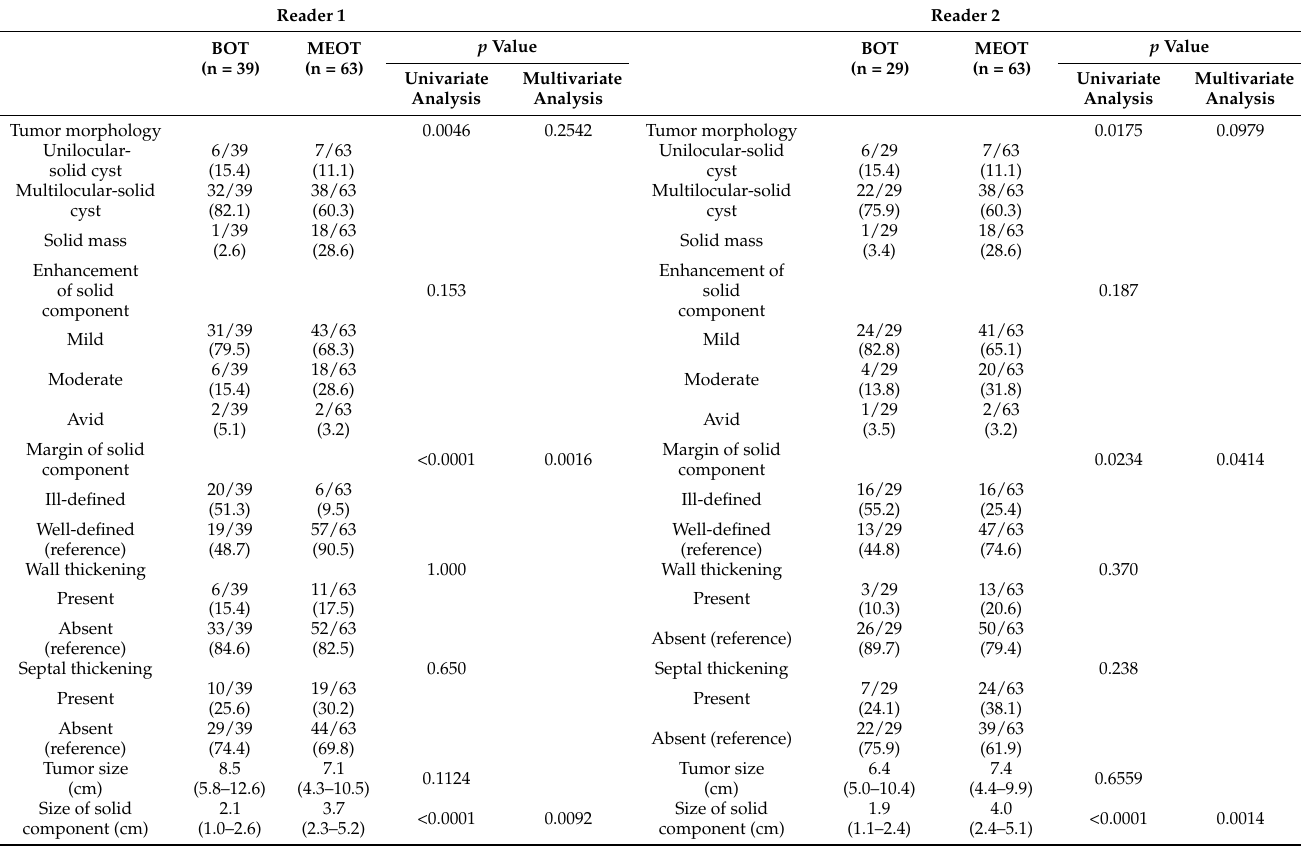
Table 3. Comparison of CT findings between BOTs and MEOTs for masses with a solid component.